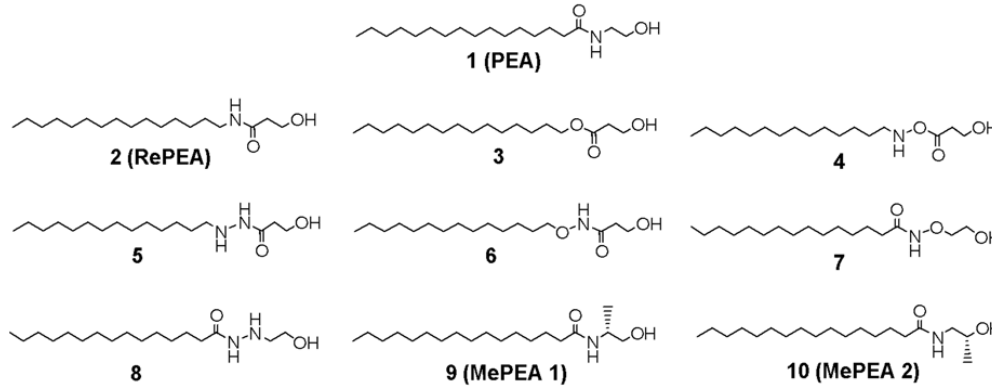
Figure 1. Chemical structures of PEA (palmitoylethanolamide) and its analogues.